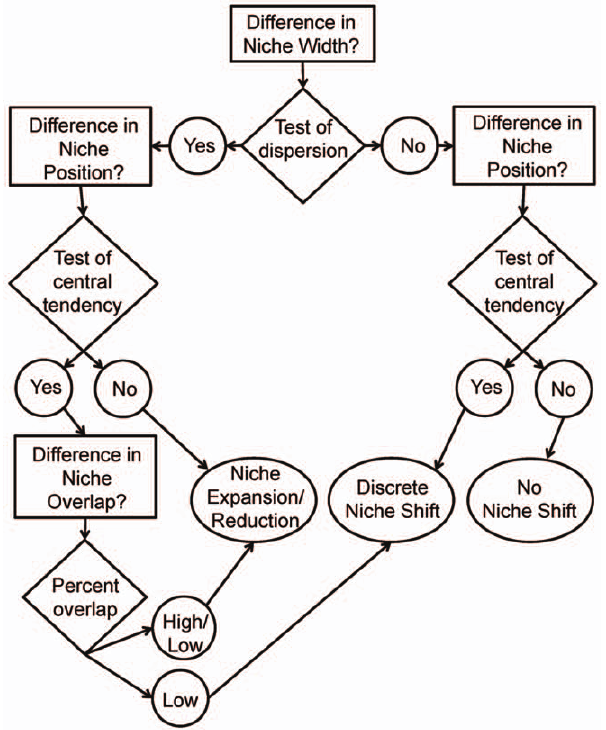
Figure 2. Flow chart of our method. Niche aspects (i.e., niche width, niche position, and niche overlap) are shown in rectangles, and test types in diamonds; ‘‘Yes’’ = niche width or niche position differs between size classes, ‘‘No’’ = niche width or niche position does not differ between size classes. The three possible scenarios are represented in ovals, with ‘‘No Niche Shift’’ = first scenario, ‘‘Niche Expansion/ Reduction’’ = second scenario, and ‘‘Discrete Niche Shift’’ = third scenario. Low = low niche overlap for both size classes; High = high niche overlap for both size classes; High/Low = asymmetric niche overlap between two size